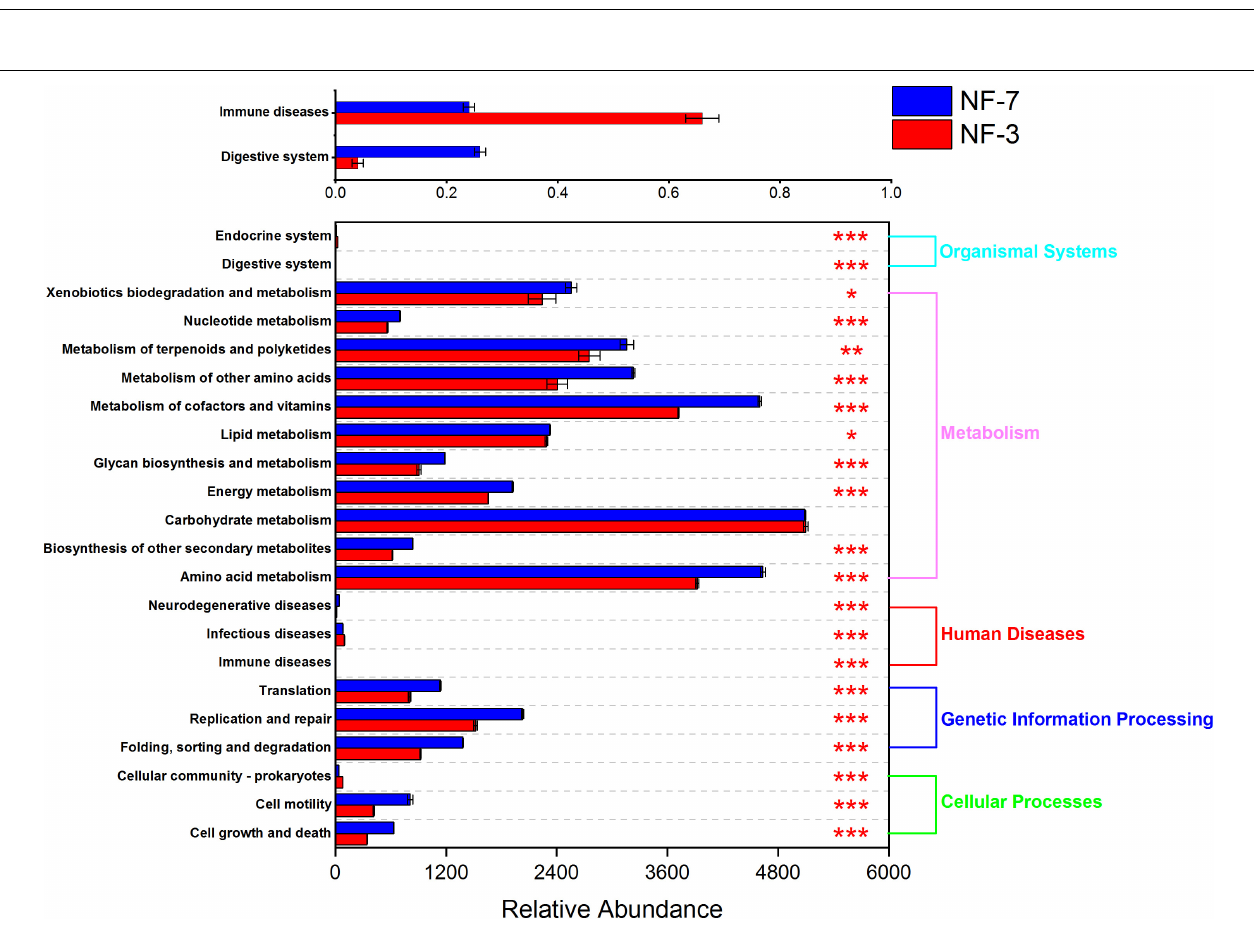
FIGURE 4 | Relative abundance of metabolic pathways at KEGG level 2. Abundance and differences in the predicted functional metagenomes of the sour porridge microbiota. Comparison of the functional pathways of microbes in the NF-3 group and NF-7 group at KEGG level 2. * P < 0.05; ** P < 0.01; *** P < 0.001.